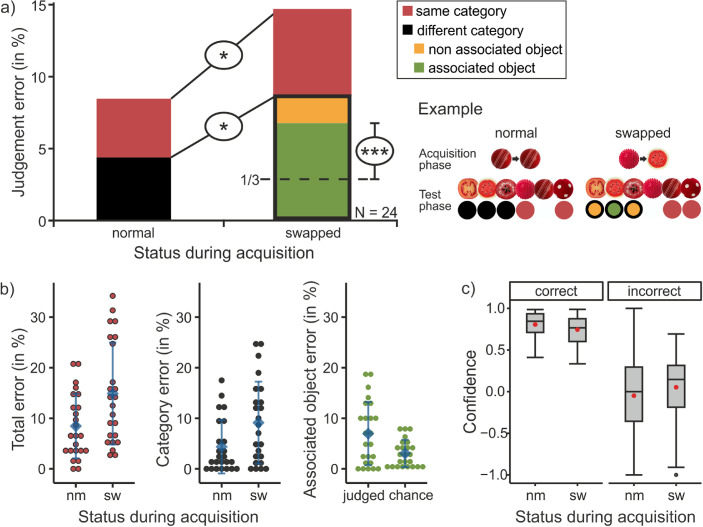
Results of Experiment 1. (a) Mean judgment errors (in percentages) in the test phase dependent on the object status during the acquisition phase (normal vs. swapped). Colors differentiate between the different kind of error types (the characteristics of the incorrectly chosen response). Next to the bar chart, one example is depicted: how the objects appeared in the periphery and the fovea during the acquisition phase, the possible responses that could be given when this object was presented during the test phase, and the kind of error this resulted in (color coded the same as in the bar chart). (b) The three comparisons that were made (and depicted in (a) via the black ellipses) depicted again with individual data points. On the left, the total percentage of judgment errors and in the middle the percentage of category errors are shown as a function of the status. The right graph shows how often the associated object was (falsely) chosen for the swapped objects (= “judged”) compared to what would be expected according to chance (one third of the different category rate). The blue diamond shows the respective mean, and the error bars represent the standard deviation across participants. For (b) and (c), “nm” is short for normal, and “sw” is short for swapped. (c) Boxplots of the confidence ratings dependent on whether the response was correct (left) or incorrect (right) and the status of the object during the acquisition phase (normal vs. swapped). The confidence rating ranged from “guessing” (= −1), “maybe” (= 0), to “highly confident” (= 1). Red circle: mean confidence rating.